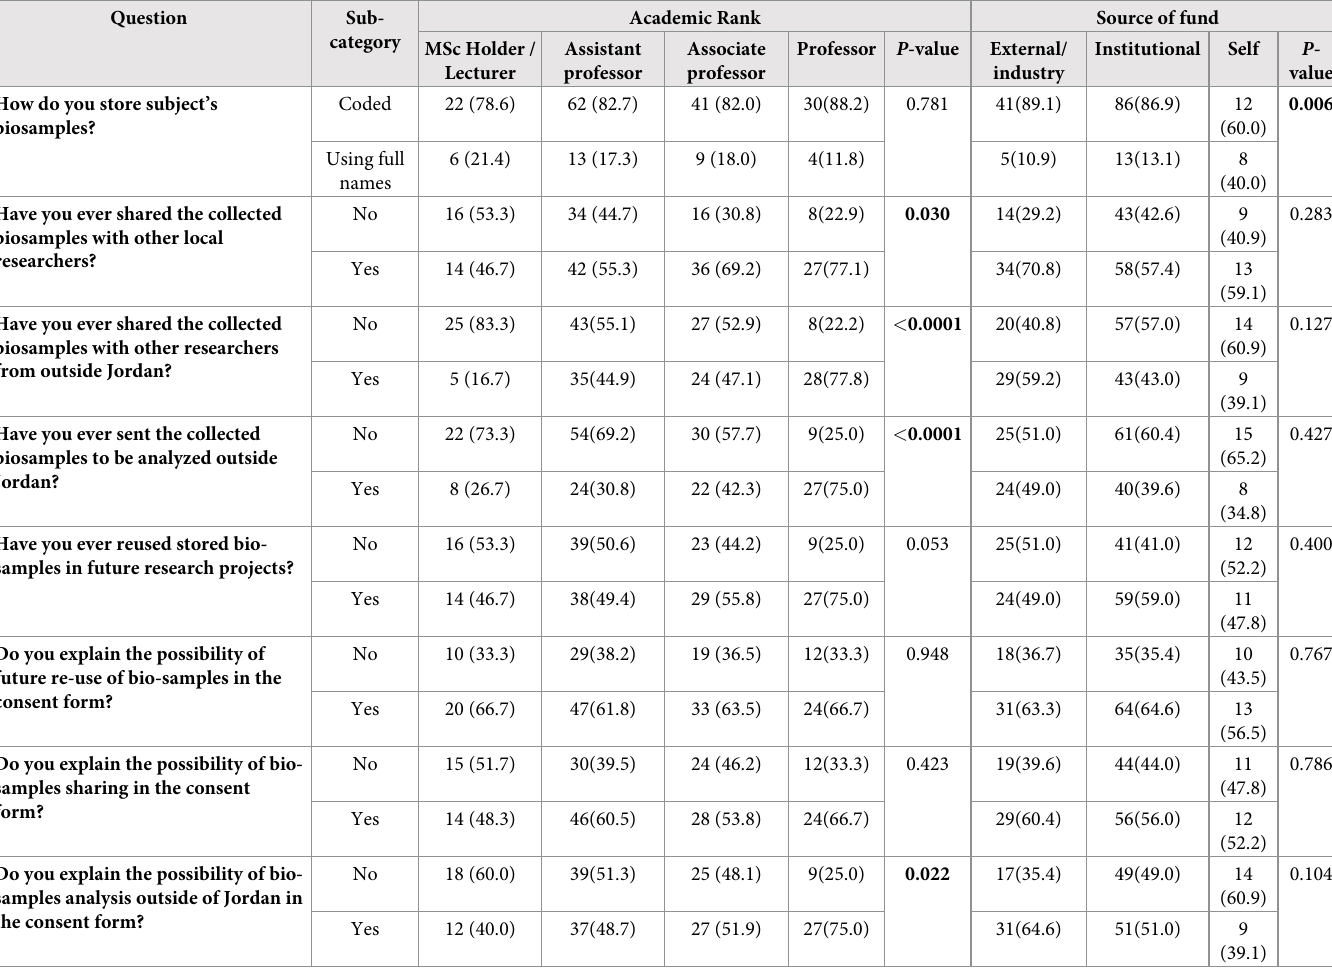
Table 4. Storage, analysis, and sharing of bio-samples among researchers in Jordan N (%), Crosstab